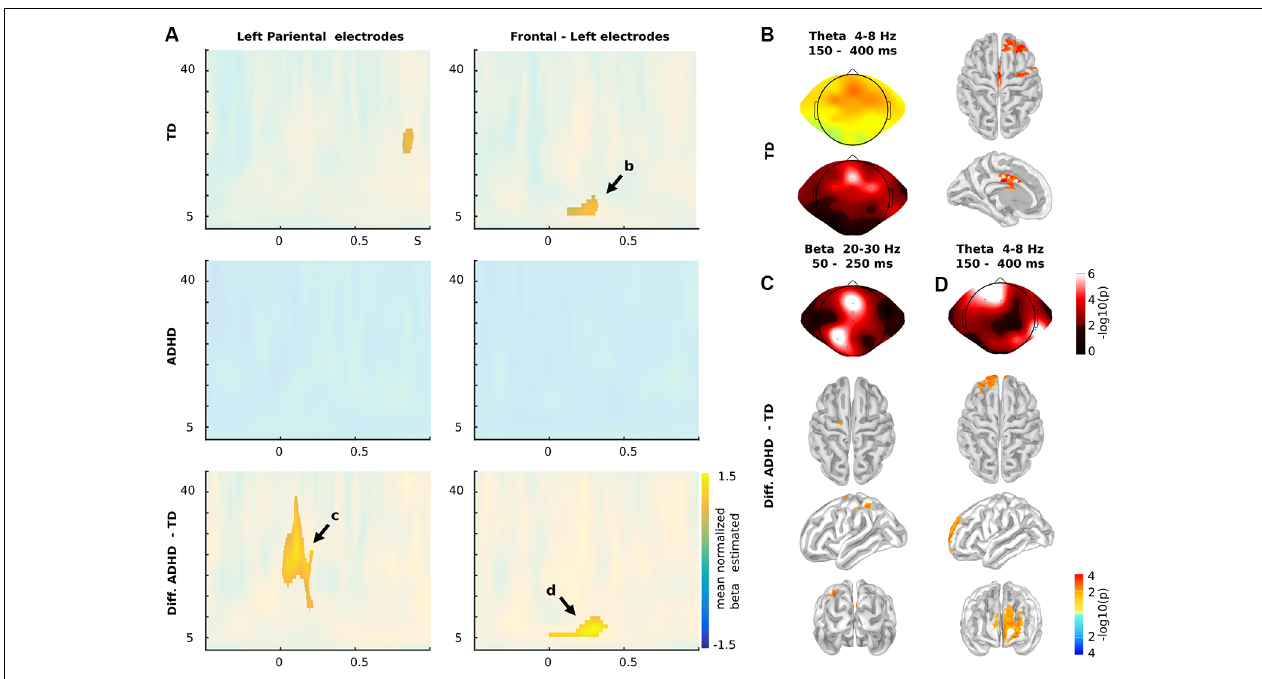
FIGURE 3 | Time-frequency results. (A) Time-frequency charts for Nogo stimuli in Left Parietal (left panels) and frontal electrodes (right panels), for TD children (upper panels), children with ADHD (middles panels) and the differences between both groups (Diff: ADHD—TD; lower panels). (B) Theta oscillatory activity (4–8 Hz) between 150 and 400 ms post stimuli presentation in both scalp (mean of beta estimated and p -values) and source levels for TD children as indicated in (A) . (C) Statistical differences between TD and ADHD children in the Beta oscillatory activity as indicated in ( A ; 20–30 Hz, 50–250 ms). (D) Statistical differences between TD and ADHD children in the Theta oscillatory activity as indicated in (A) . (A–C) Color represents the mean across subjects of the normalize beta estimated (beat/standard error of the mean) of the individual correlation between the power of the oscillatory brain activity and the sequences of Go stadium that precede the Nogo stimulus. The clusters with significant effects are highlighted ( p < 0.01 cluster-corrected). (C,D) Color represents the p -values of the differences between groups. (B–D) For source levels, color represents the p -values at a threshold of q < 0.05 (FDR